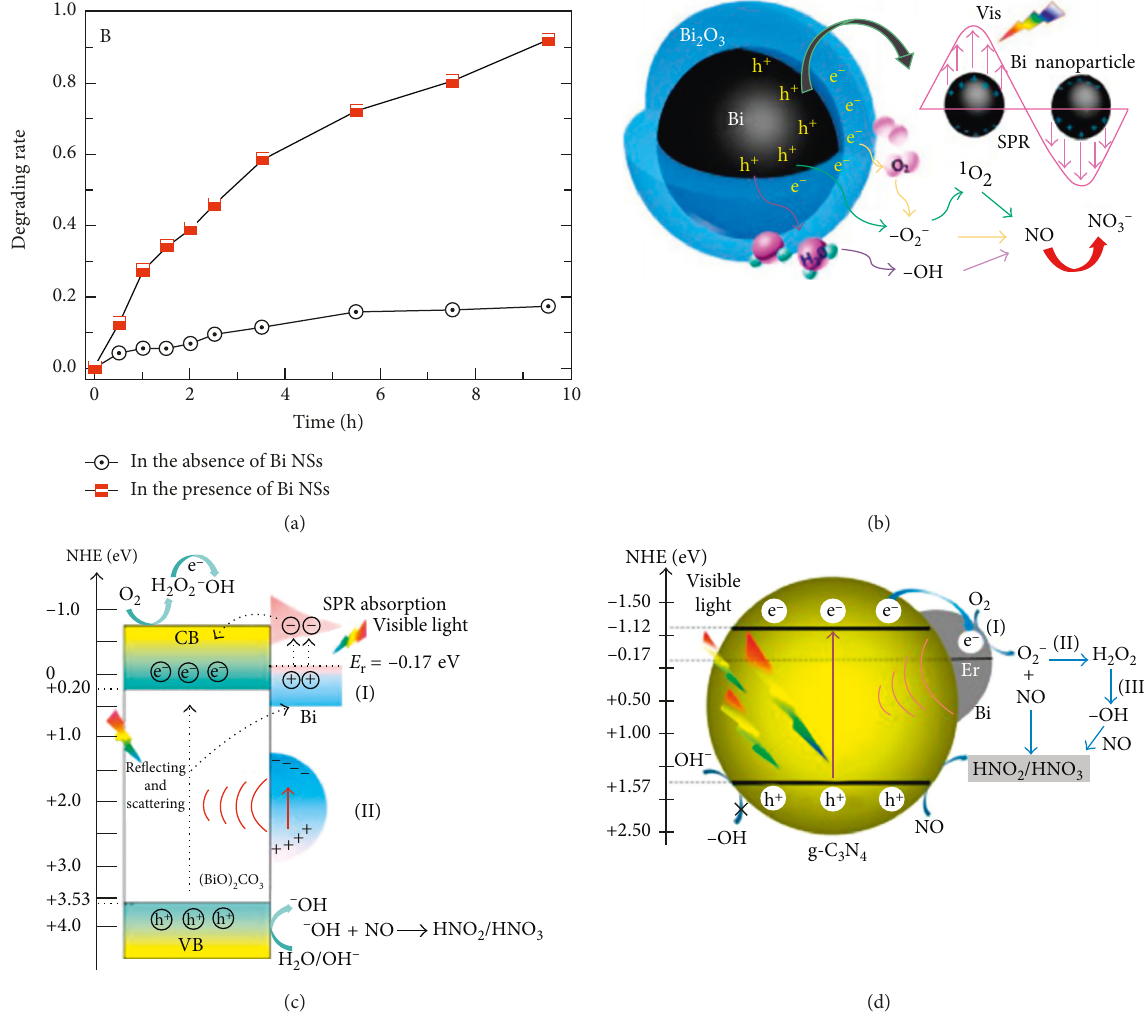
Figure 12: (a) Example of the photocatalytic effect of Bi nanospheres on the degradation rate of MO (reprinted from [54] © 2013, American Chemical Society). (b) Proposed mechanism for direct photocatalysis by a Bi nanosphere (reprinted with permission from [99] © 2017, American Chemical Society). (c) Proposed mechanism for the cocatalytic degradation of NO where Bi nanostructures act as an electron donor (reprinted with permission from [121] © 2014, American Chemical Society, under ACS AuthorChoice license). (d) Proposed mechanism for the cocatalytic degradation of NO where Bi nanostructures act as an electron acceptor (reprinted with permission from [105] © 2015, American Society of